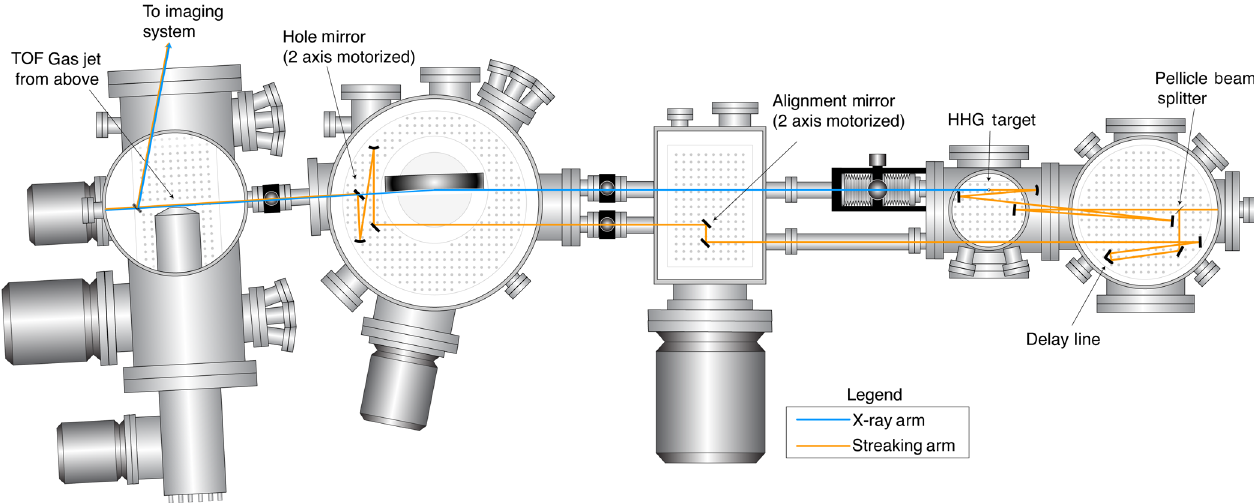
FIG. 3. Schematic layout of the attosecond streaking beam line. Five interconnected vacuum chambers make up the attosecond streaking beam line. Following the beam propagation direction, from right to left, the first two chambers are only rough pumped to facilitate the high gas pressures needed for phase-matched HHG, and the last three chambers are turbopumped to minimize reabsorption of the x rays and ensure the required pressure environments needed by the diagnostics in the last chamber